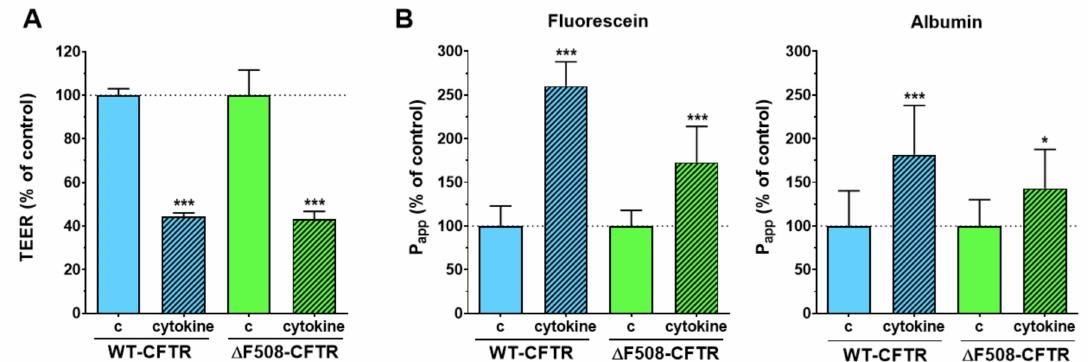
Figure 5. Transepithelial electrical resistance (TEER) ( A ) and permeability values ( B ) of co-cultures after a 6-h cytokine treatment. Values are presented as a percentage of control groups. Means ± SD, n = 4 / group. Statistical analysis: 2-way ANOVA and Bonferroni test. * p < 0.05, *** p < 0.001 compared to the control groups.